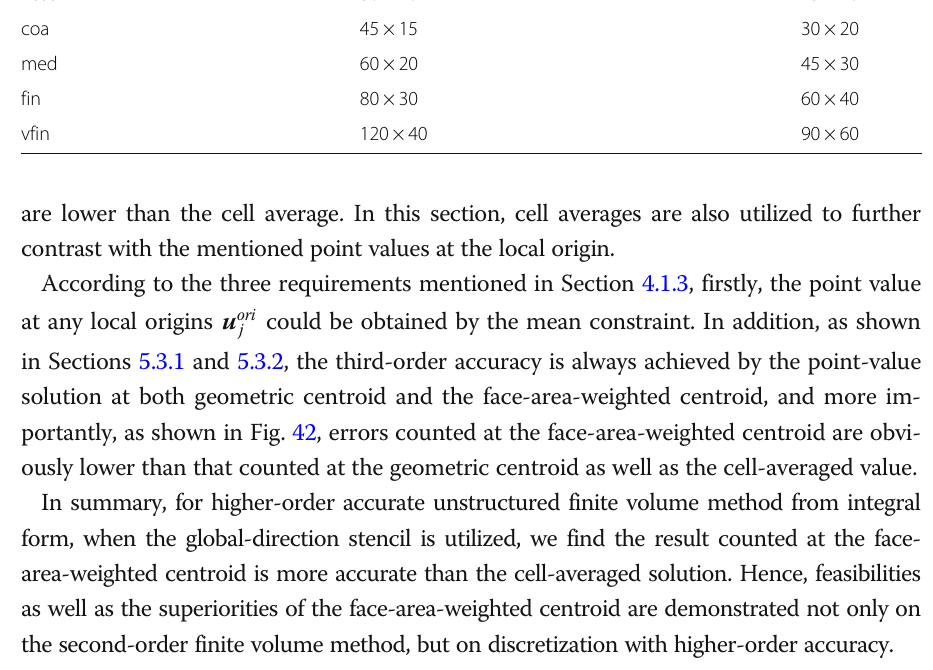
Table 10 Distribution of background quadrilateral grids in x and y directions Grid name